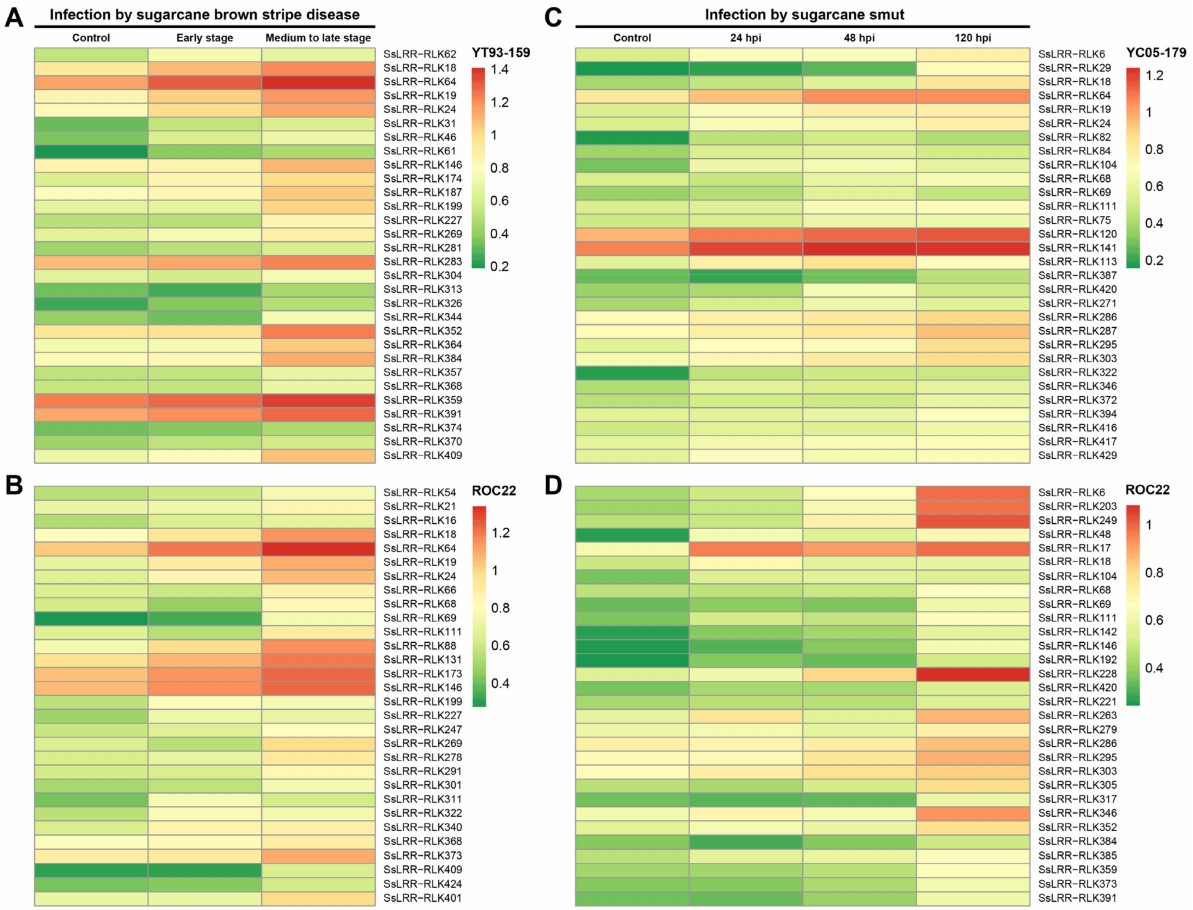
Figure 5. Heatmaps of the expression analysis of SsLRR-RLKs under different biotic stresses. The differential expression patterns in two different sugarcane varieties were shown by heatmap under ( A , B ) infection by sugarcane leaf blight disease and ( C , D ) infection by sugarcane smut. Heatmap was generated based on FPKM values. The color scale represents expression values of each sample, with red showing high levels and green showing low levels of transcript